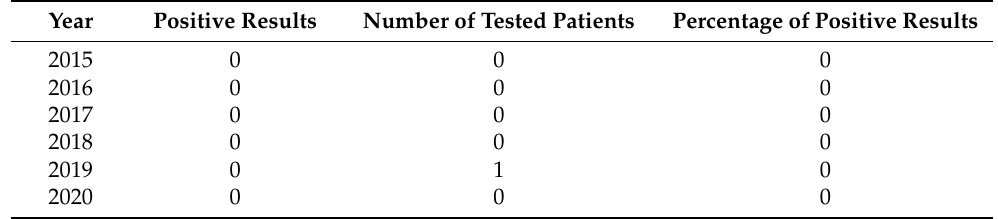
Table 16. Anti-mannan Candida antibodies in NICU